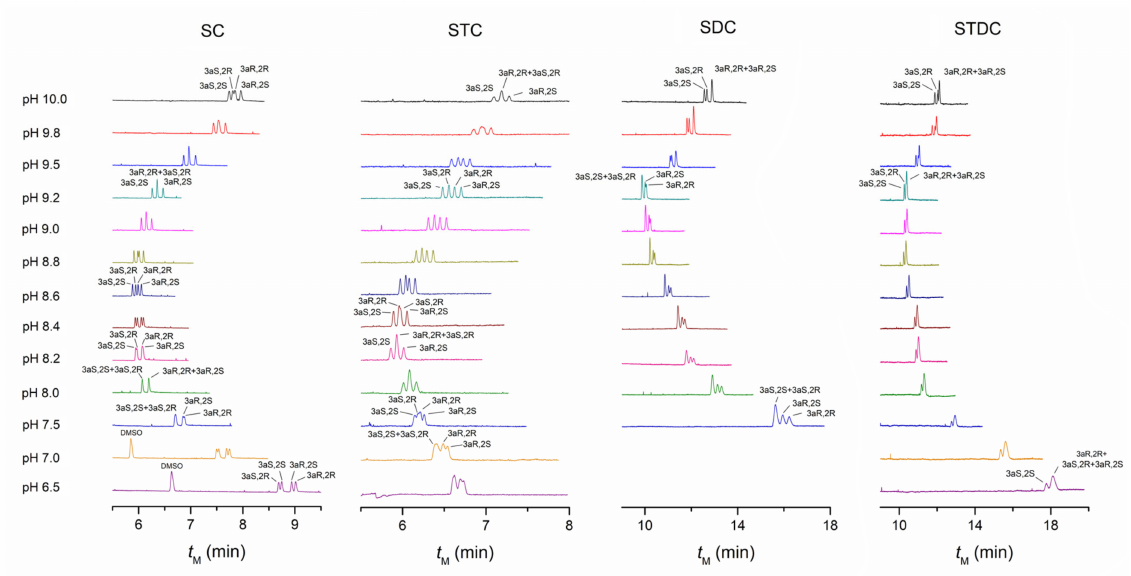
Figure 1. Electropherograms of PALO stereoisomers obtained with four bile salts at different pHs. Component of micellar solution is 30 mM each bile salt in 30 mM sodium tetraborate buffer. Capillary: id 50 µ m, L tot 60.0 cm, L eff 50.0 cm. Capillary temperature: 20 ◦ C. Detection wavelength: 214 nm for SC and SDC, 254 nm for STC and STDC. Sample concentration: 0.1 mg · mL − 1 for each stereoisomer. Hydrodynamic injection at 5 kPa for 2 s. Applied voltage: 25 kV. Table 1. The separation parameters of four bile salts at pH 9.2 for PALO stereoisomers a . SC STC SDC